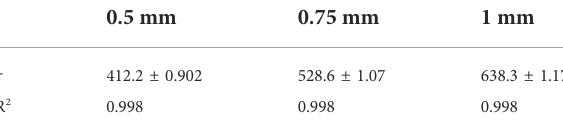
TABLE5Thepressureconstant τ indifferentmembranethicknessesof the balloon actuators were calculated by exponential growth curve fi tting with high R 2